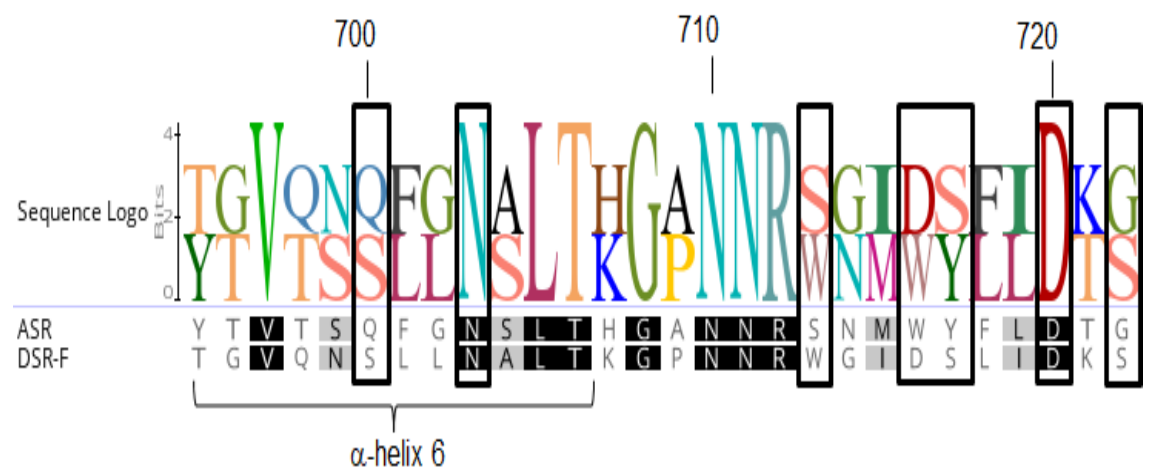
Figure 6. Surface binding site (SBS-A1) sequence comparison. Alignment of the residues corresponding to SBS-A1 of alternansucrase ASR (in black boxes) from L. citreum NRRL B-1355 (numbered and α-helix 6 according to ASR in complex with isomaltotriose, PDB entry 6SYQ) with the equivalent residues in dextransucrase DSR-F.